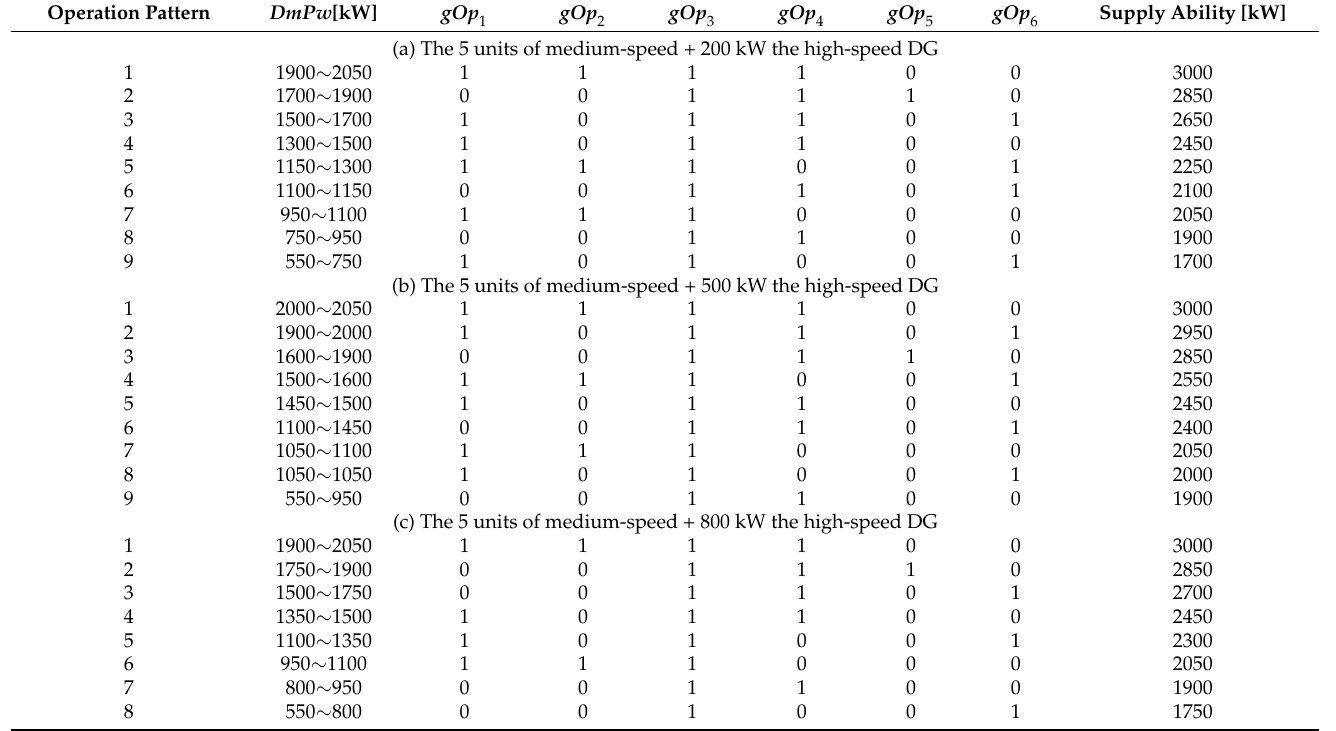
Table 7. The unit selection of the five units of medium-speed with one unit of high-speed DGs operated by the conventional load sharing